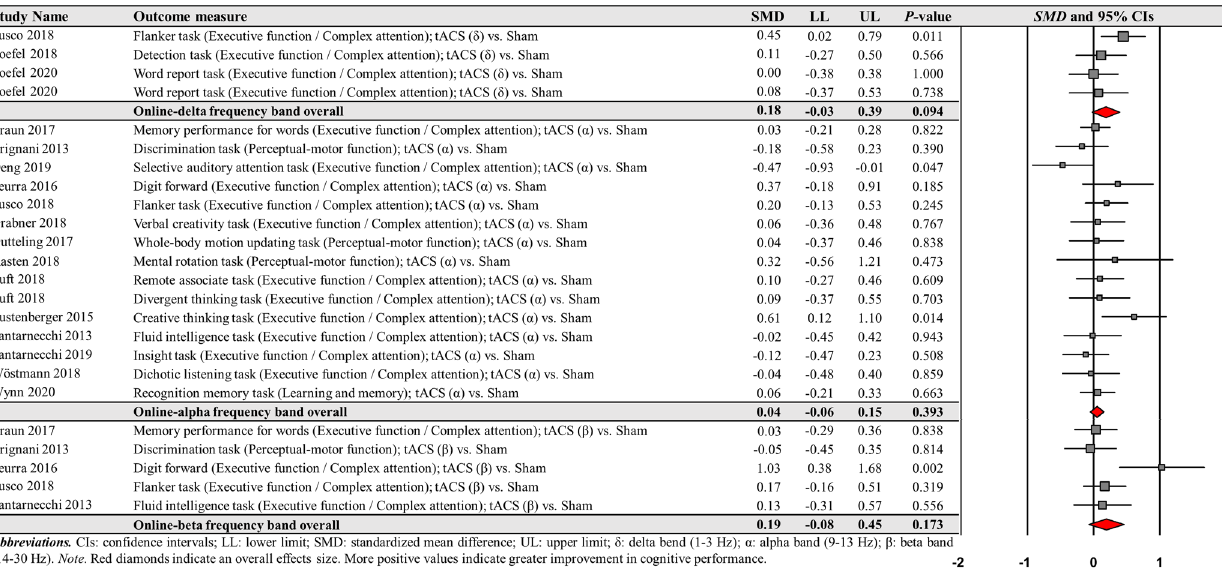
Fig. 6 Cognitive performance comparisons after online-tACS with delta, alpha, and beta frequency bands. Meta-analytic fi ndings show no signi fi cant effects of online-tACS protocols with delta, alpha, and beta frequency bands on changes in cognitive performances.